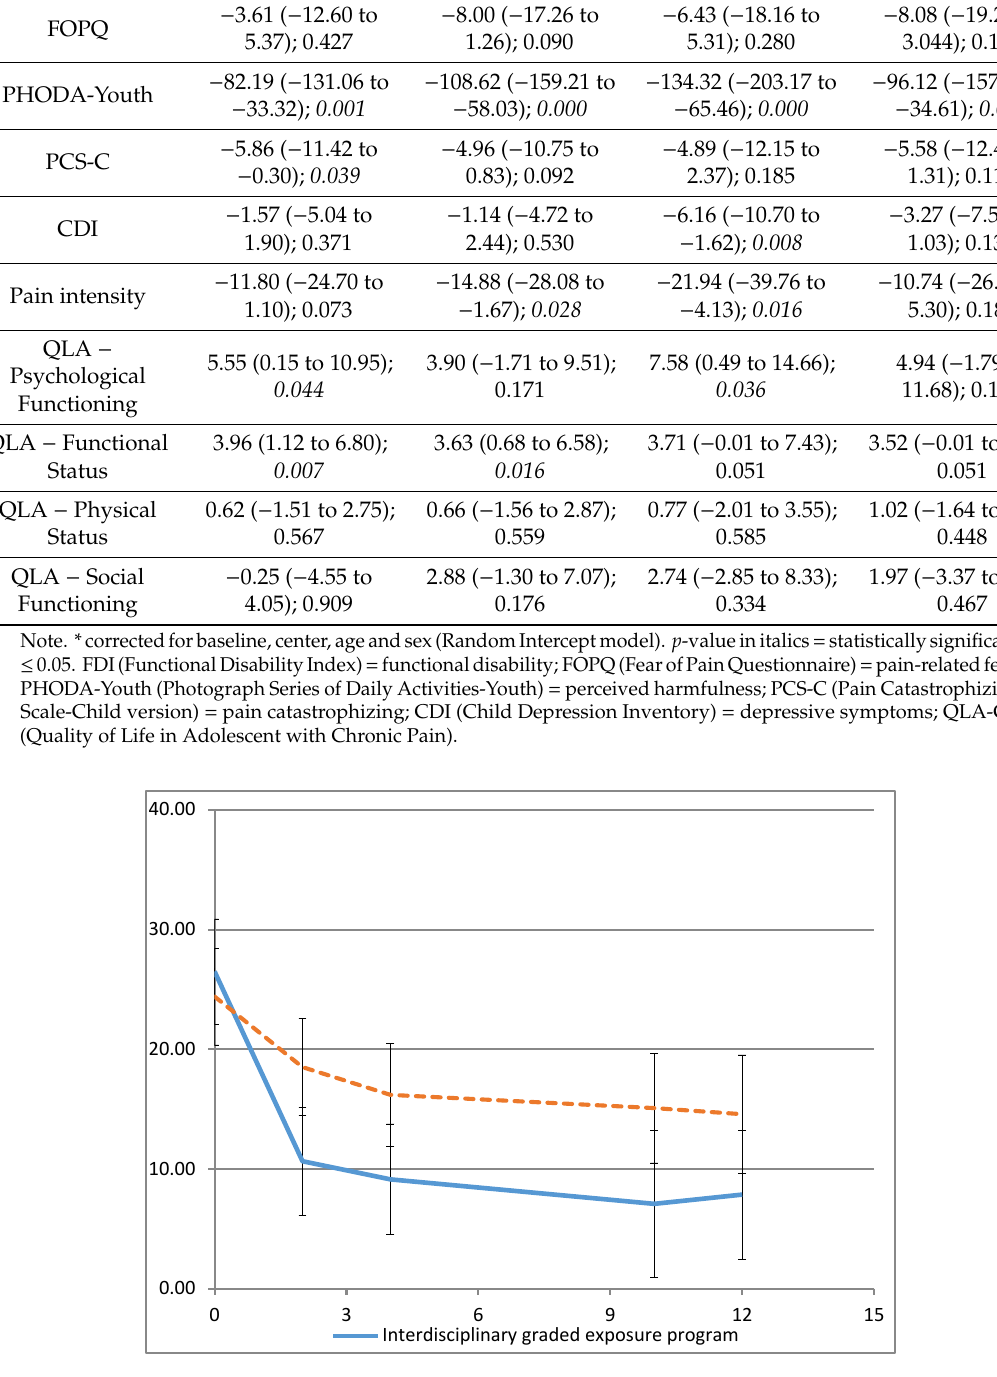
Figure 2. Estimated mean group scores on the FDI at baseline and after 2, 4, 10, and 12 months with 95% CI.